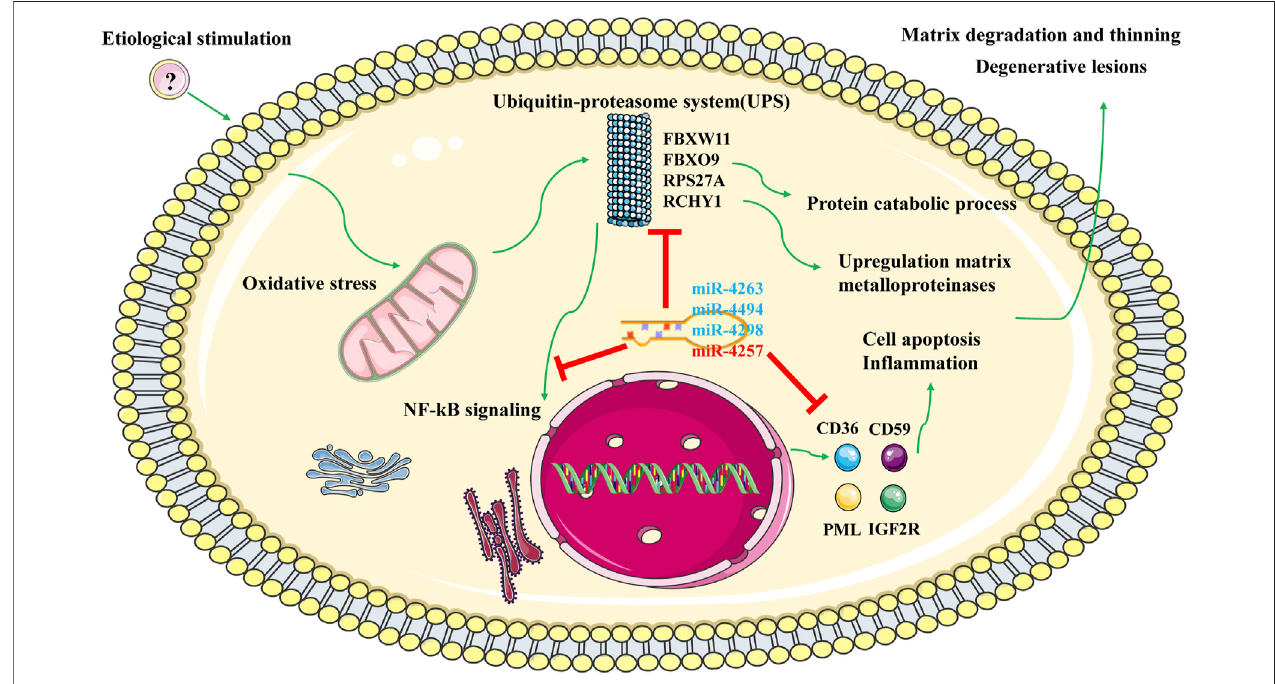
FIGURE9| PotentialregulatorymechanismofKC.Note: Green represents activationeffects;bluerepresentsdown-regulated miRNA; red representsupregulated miRNA.